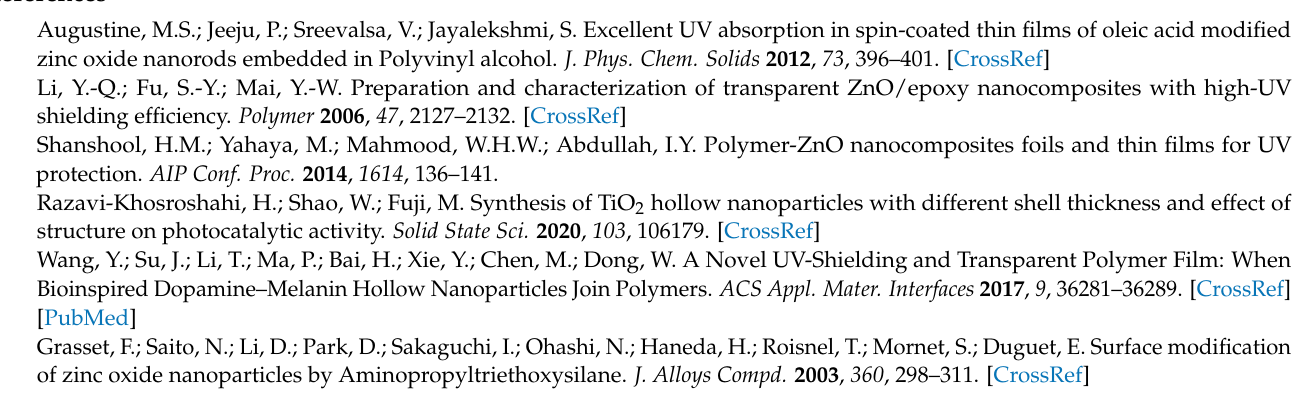
DVB, Figure S6: Photographs of PVA film and PVA films containing 1 wt% of OA-ZnO NPs, core- shell ZPPs, Pickering-like ZPPs, and hollow ZPPs coated on glass slide placed on black and white backgrounds, and Figure S7: Schematic diagram of light absorption and multi light scattering of core-shell, Pickering-like and hollow